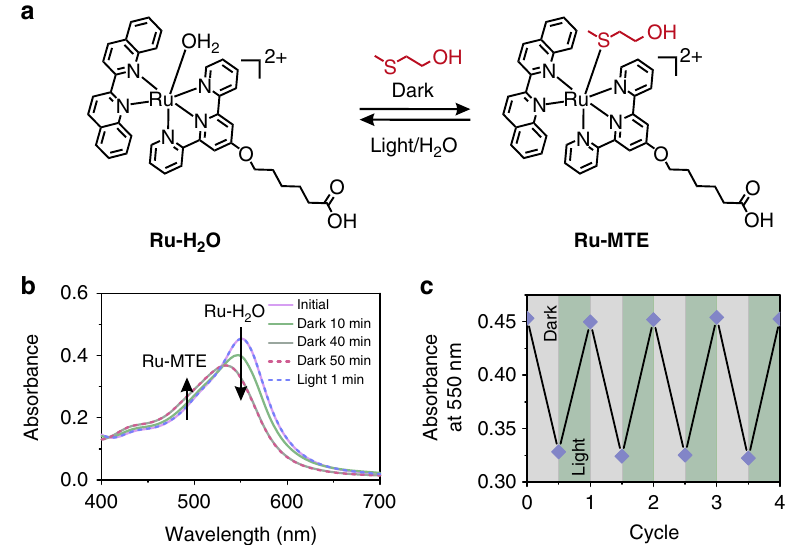
Fig. 2 Visible-light-controlled Ru – thioether coordination in solution. a Interconversion of Ru-H 2 O and Ru-MTE in solution. b UV – vis absorption spectra of an aqueous solution containing Ru-H 2 O (1 mM) and MTE (10 mM) in the dark for 10, 40, and 50 min and subsequently irradiated with green light for 1 min. c Absorption changes in the aqueous solution containing Ru-H 2 O (1 mM) and MTE (10 mM) for alternating dark/light irradiation